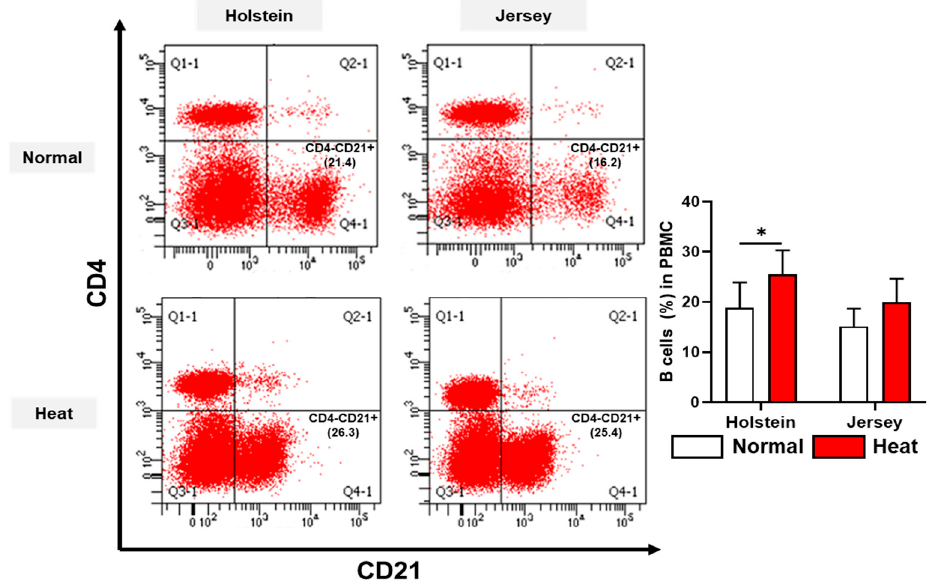
Figure 6. Alteration in blood B cells in peripheral blood mononuclear cells (PBMCs) from two breeds of dairy cow under different environmental conditions. The populations of B cells (CD4-CD21+) in Holstein and Jersey cows under normal and high-heat environmental condition were analyzed using flow cytometry. Data are represented as means ± standard deviation (SD); n = 7–8 animals/group. Values were statistically analyzed by a mixed-effects model with Tukey’s multiple comparison test. * p < 0.05.